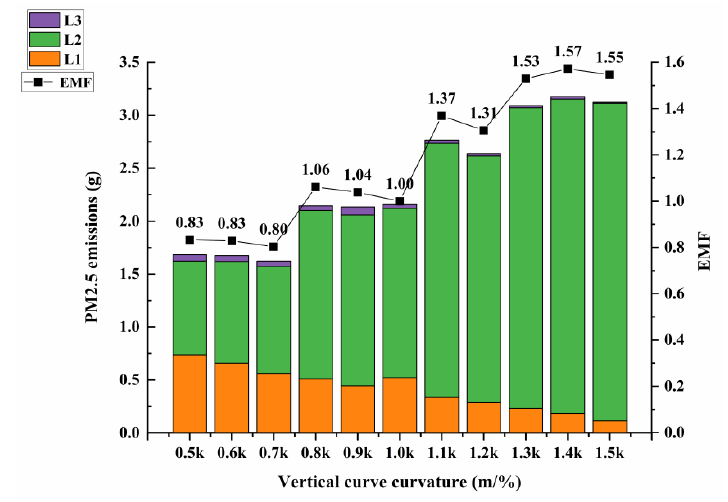
Figure 6. Relationship between PM2.5 emissions and curvature.